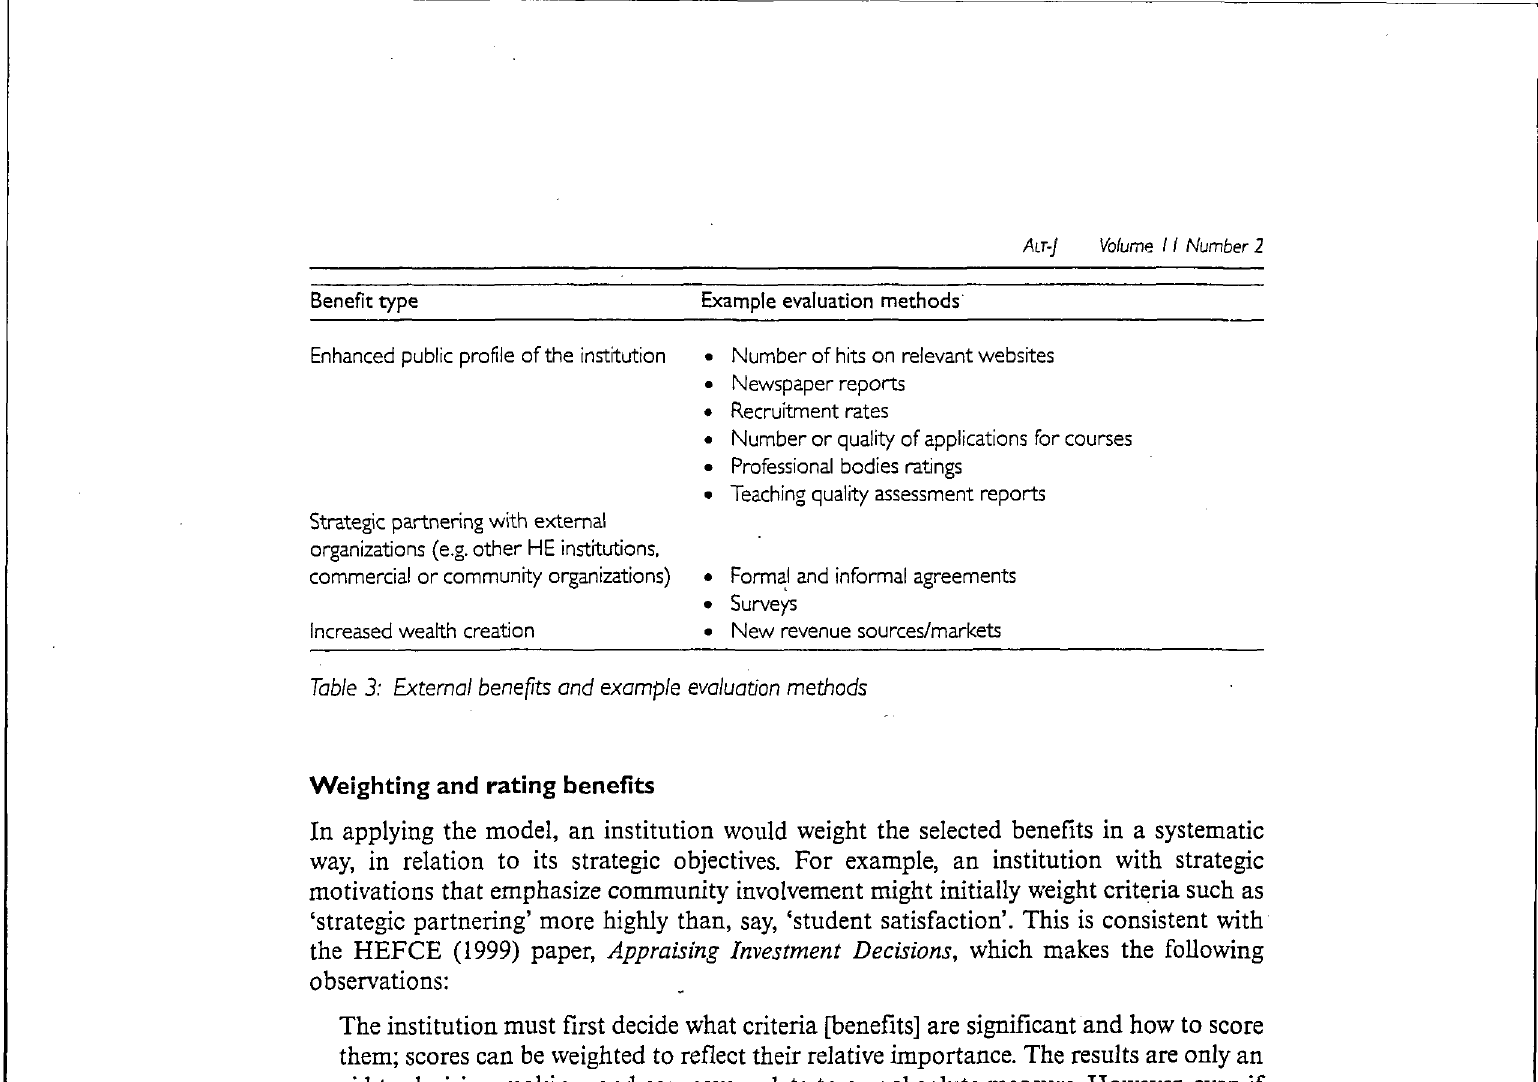
Weighting and rating